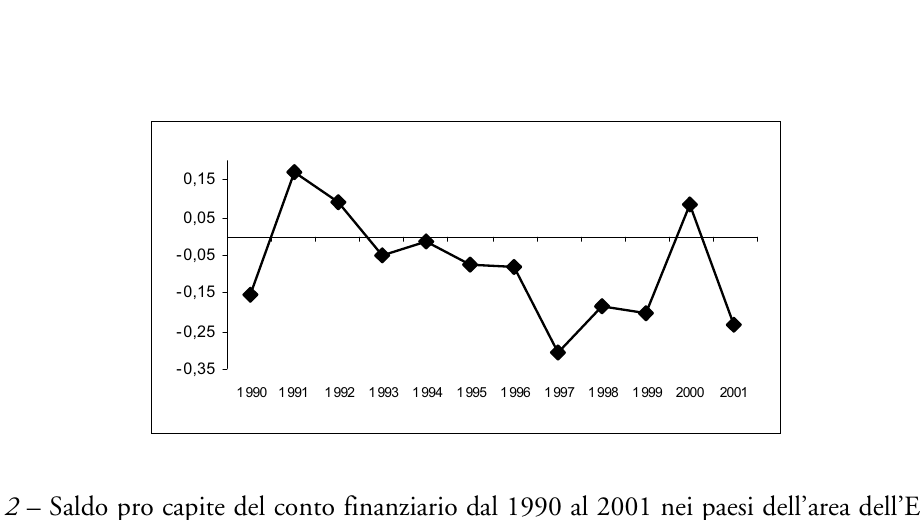
Figura 2 – Saldo pro capite del conto finanziario dal 1990 al 2001 nei paesi dell’area dell’EURO – dati annuali a prezzi 1995, migliaia di euro.